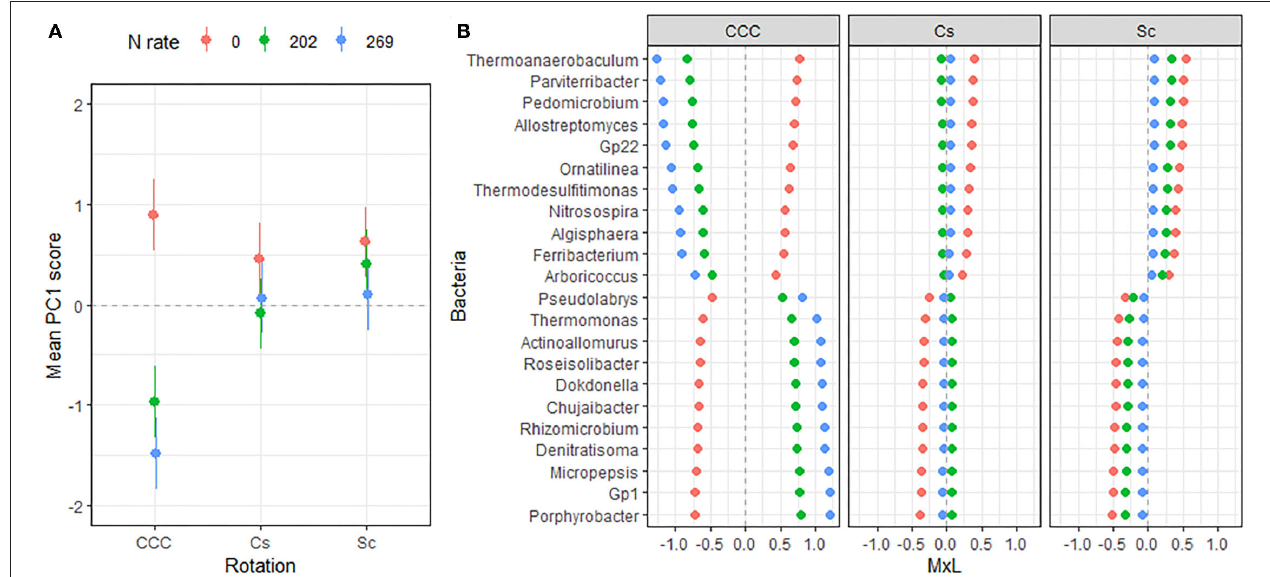
FIGURE 2 | (A) Mean value of the bacterial PC1 scores for each rotation at each level of N fertilization. Standard errors are indicated as whiskers. (B) Contribution of each indicator genera to the PC mean value (MxL) for each rotation at each level N fertilization: CCC, continuous corn; Cs, corn phase of the corn-soybean rotation; Sc, soybean phase of the corn-soybean